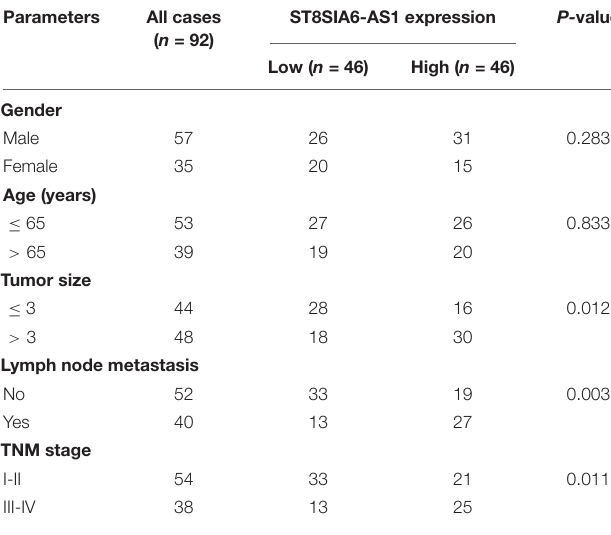
TABLE 1 | The correlations between ST8SIA6-AS1 expression and clinicopathological features in LUAD patients ( n = 92).